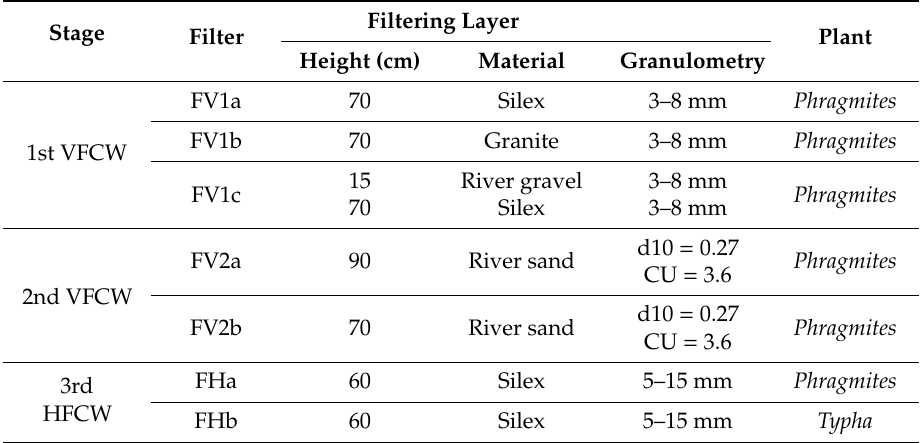
Table 1. Main design characteristics of the filters.